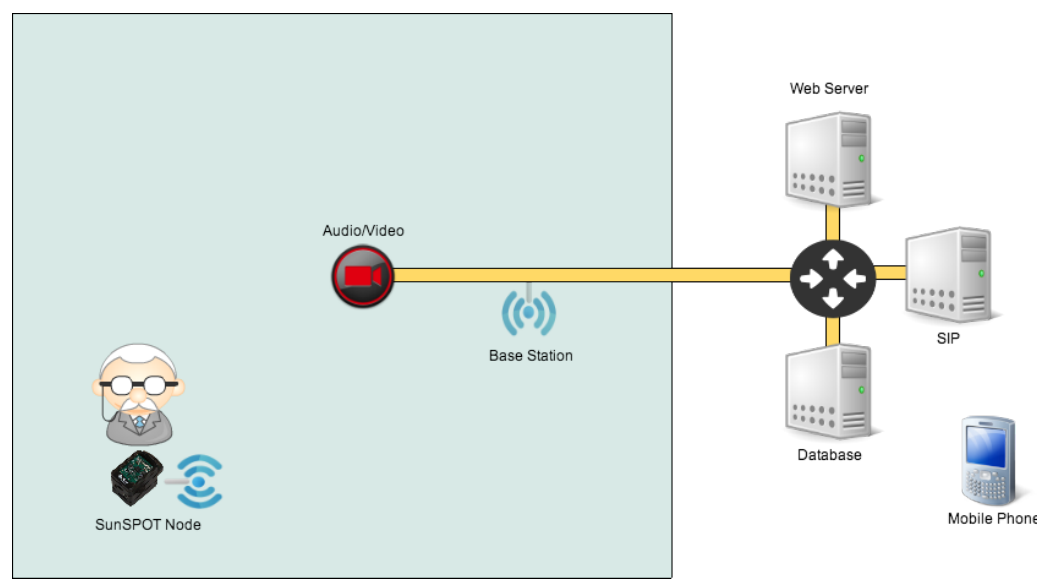
Figure 2. Schematic of test-bed